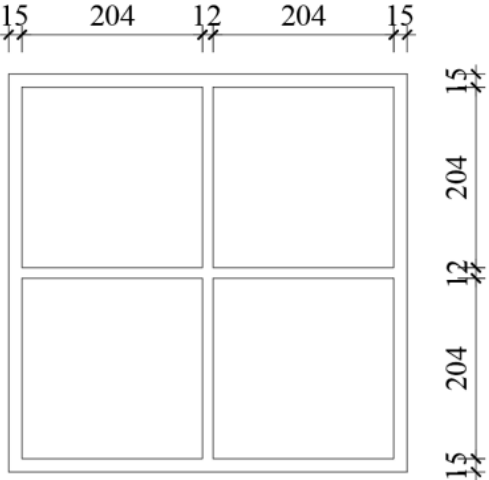
Figure 6. Cross section dimensions of the steel seat.